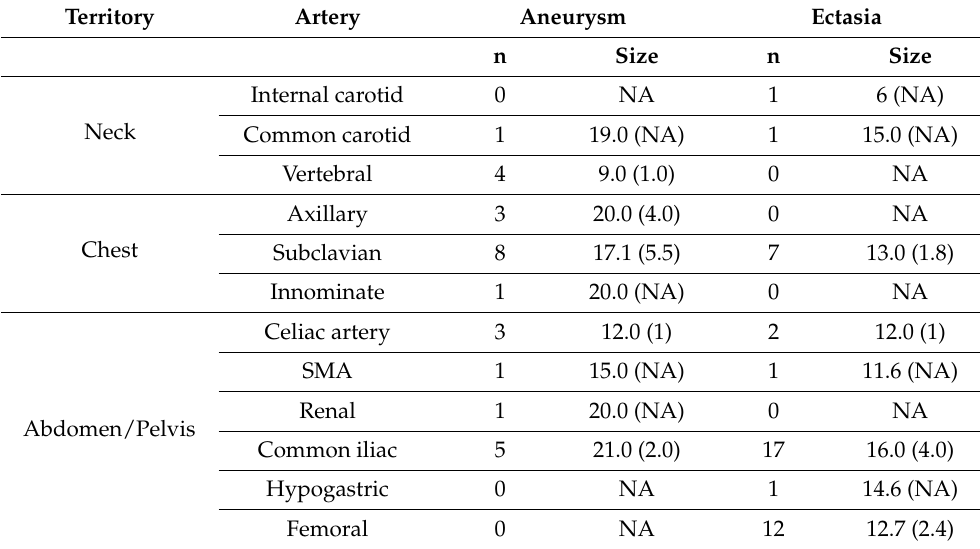
Table 3. Distribution of the primary non-aortic